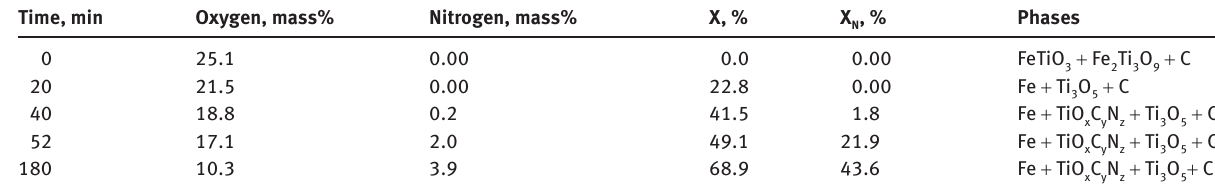
Table 5: LECO analysis and phase composition of primary ilmenite in the progress of reduction in nitrogen at 1573 K.